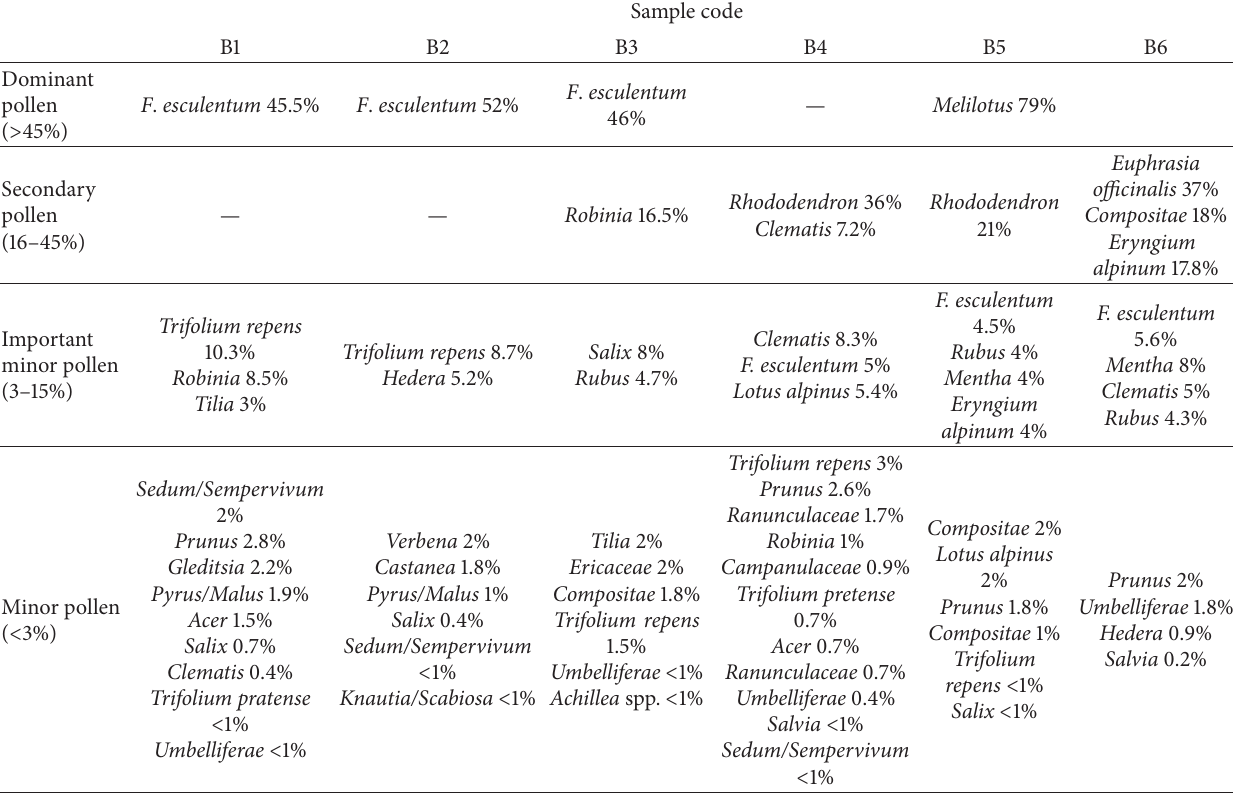
Table 2: Relative frequencies of the main pollen types in honeys labeled as buckwheat honeys. B1, B2, and B3: buckwheat honey from Italy (Valtellina); B4, B5, and B6: buckwheat honey from Italy (Teglio).